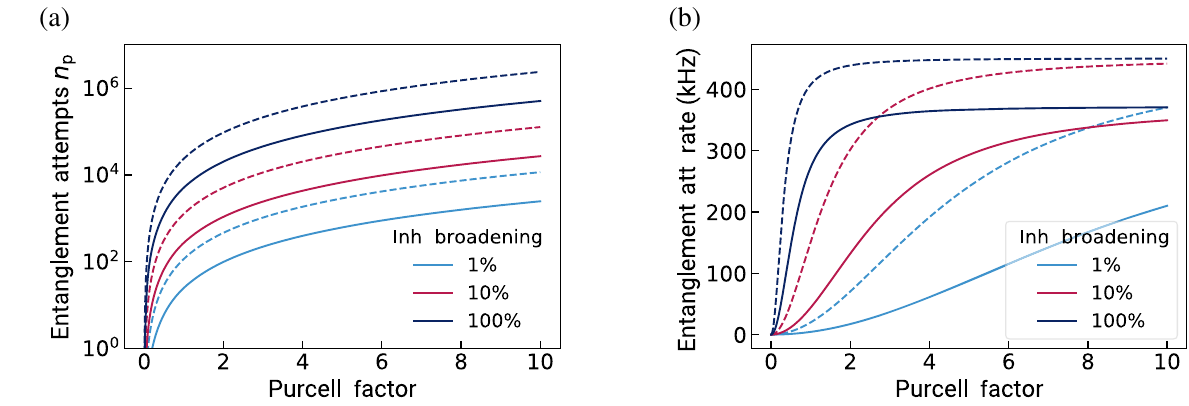
FIG. 8. Modified version of Fig. 5. We add to the proposal of entanglement generation (solid lines) the results of a modified protocol without considering resonant optical spin-repump pulses at 637 nm (20 nW, 1 μ s) before every entanglement attempt (dashed